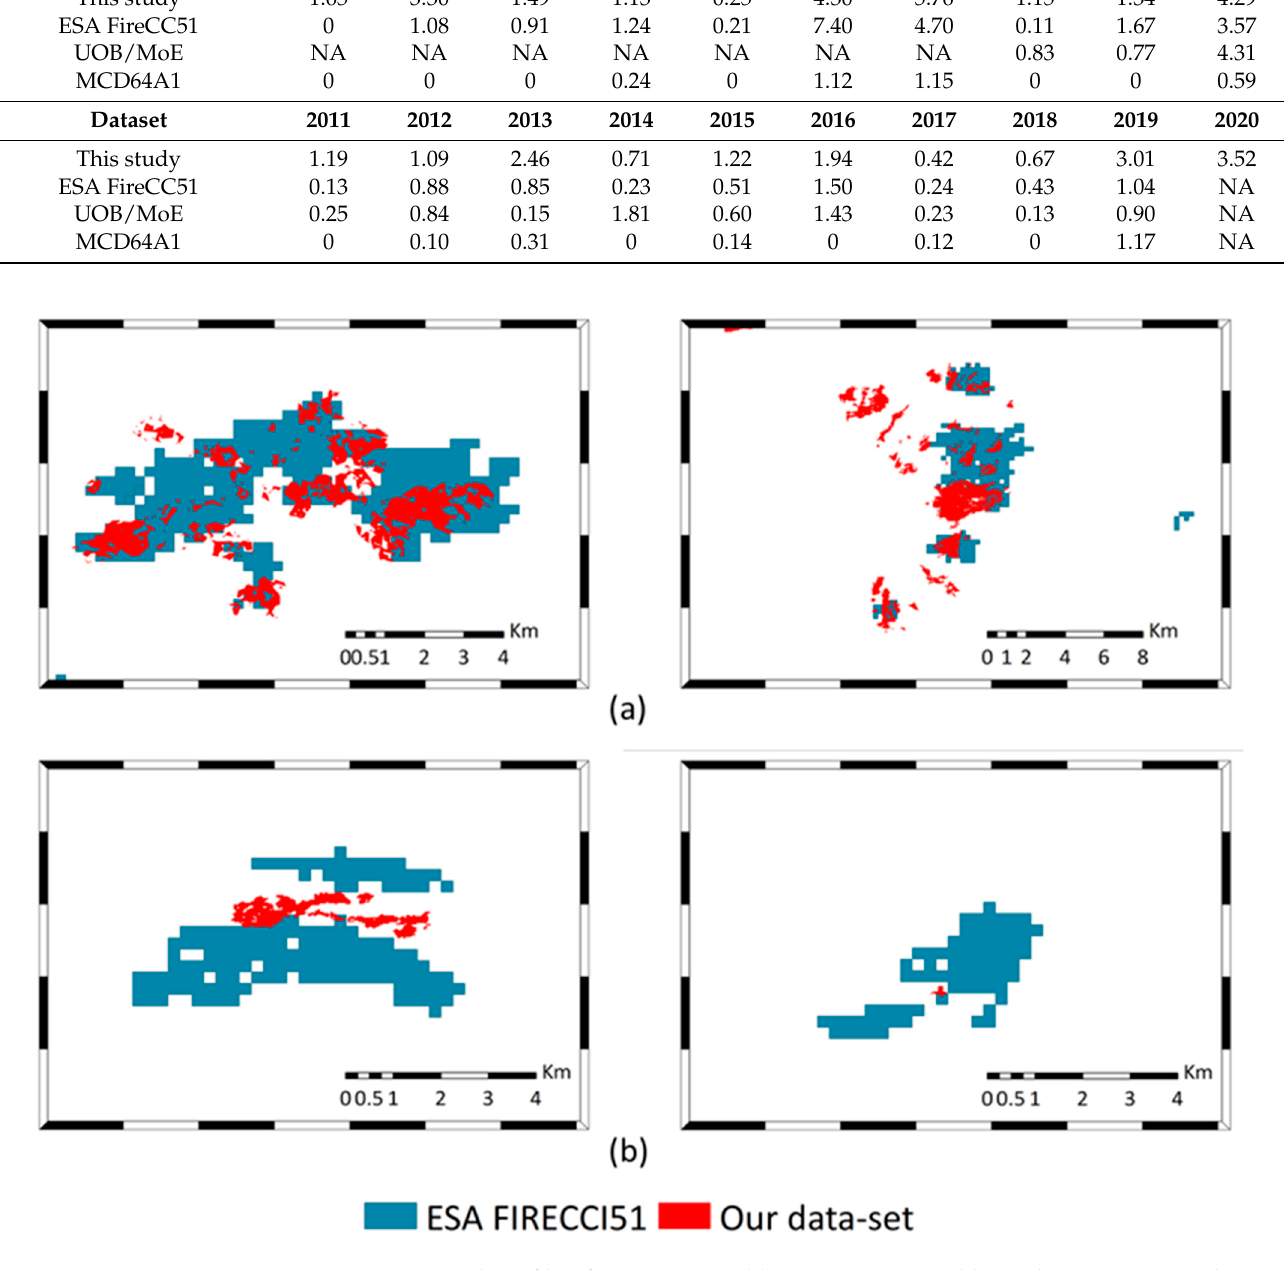
Figure 5. A number of big fires as captured by ESA FireCCI51 (blue polygons) compared to our method (red polygons) in ( a ) 2006 and ( b ) 2010.